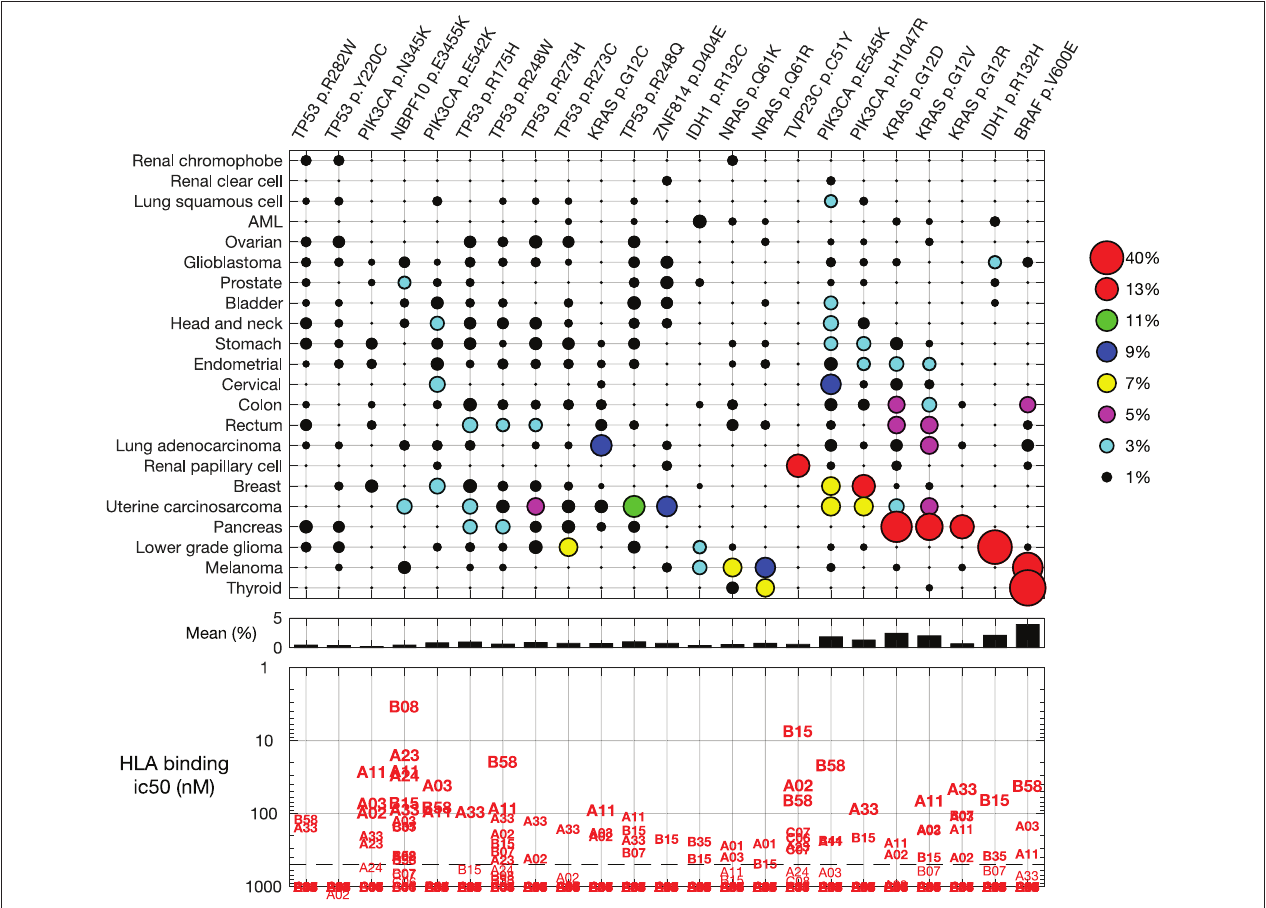
FIGURE 4 | Common mutations across all indications and their predicted HLA binding. (Top) Non-synonymous mutations found in at least 10% of the samples in any one indication. Indications and mutations are clustered. (Middle) The mean frequency across indications. (Bottom) Predicted binding for each mutation to common HLA class I